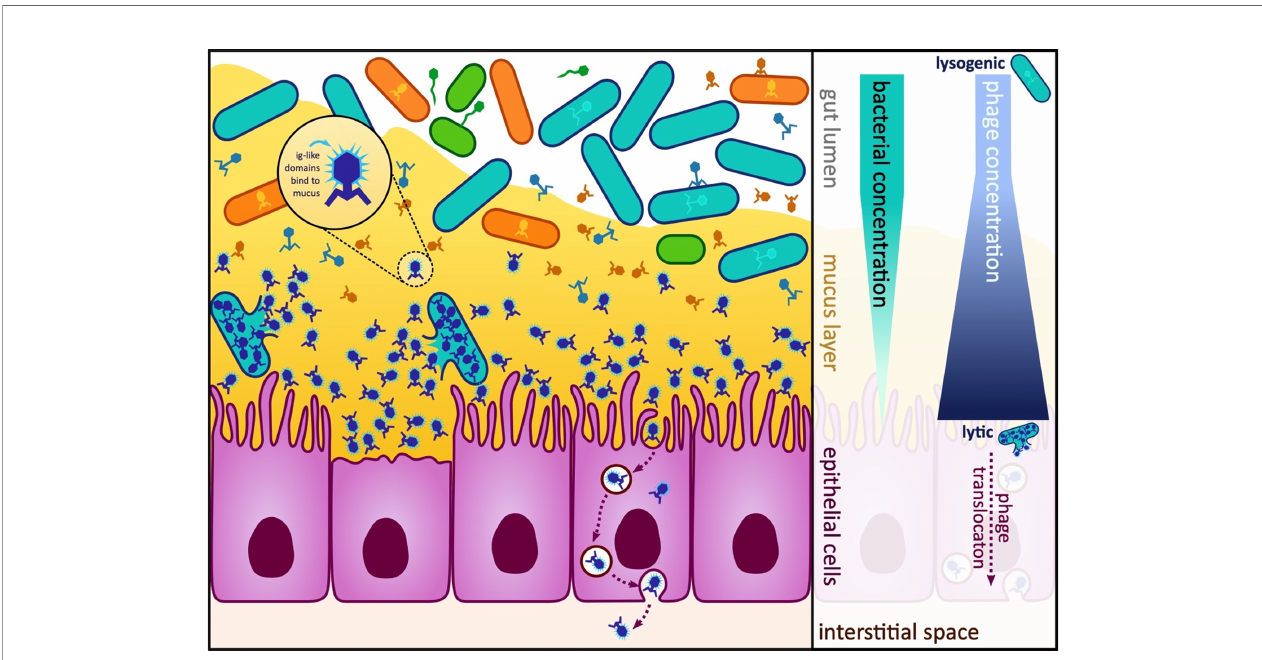
FIGURE 4 | Diagram of the gut and bacterial and phage concentrations in the lumen, mucosa and epithelial cells. In the human gut, multiple different host-prey dynamics are theorised to occur dependent on the proximity to the gut mucosa. At the top of the mucosa, viruses take a lysogenic strategy or “ piggyback-the- winner ” as hosts are abundant here. Deeper within the mucosa, the viruses switch to a lytic or “ kill-the-winner ” strategy as at this point the bacteria are less abundant (Silveira and Rohwer, 2016). (Right) Some phages encode Ig-like domains that allow them to bind to the mucosa and evade the immune system, (Left) Phages can undergo transcytosis and be engulfed and transported through epithelial